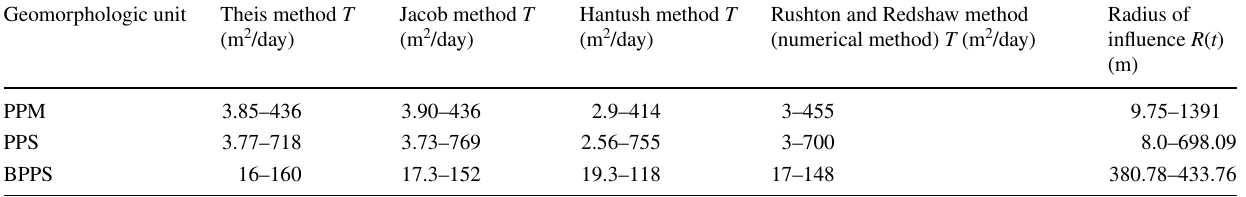
Table 3 Variation of transmissivity estimated by different methods and radius of influence in different geomorphologic units Geomorphologic